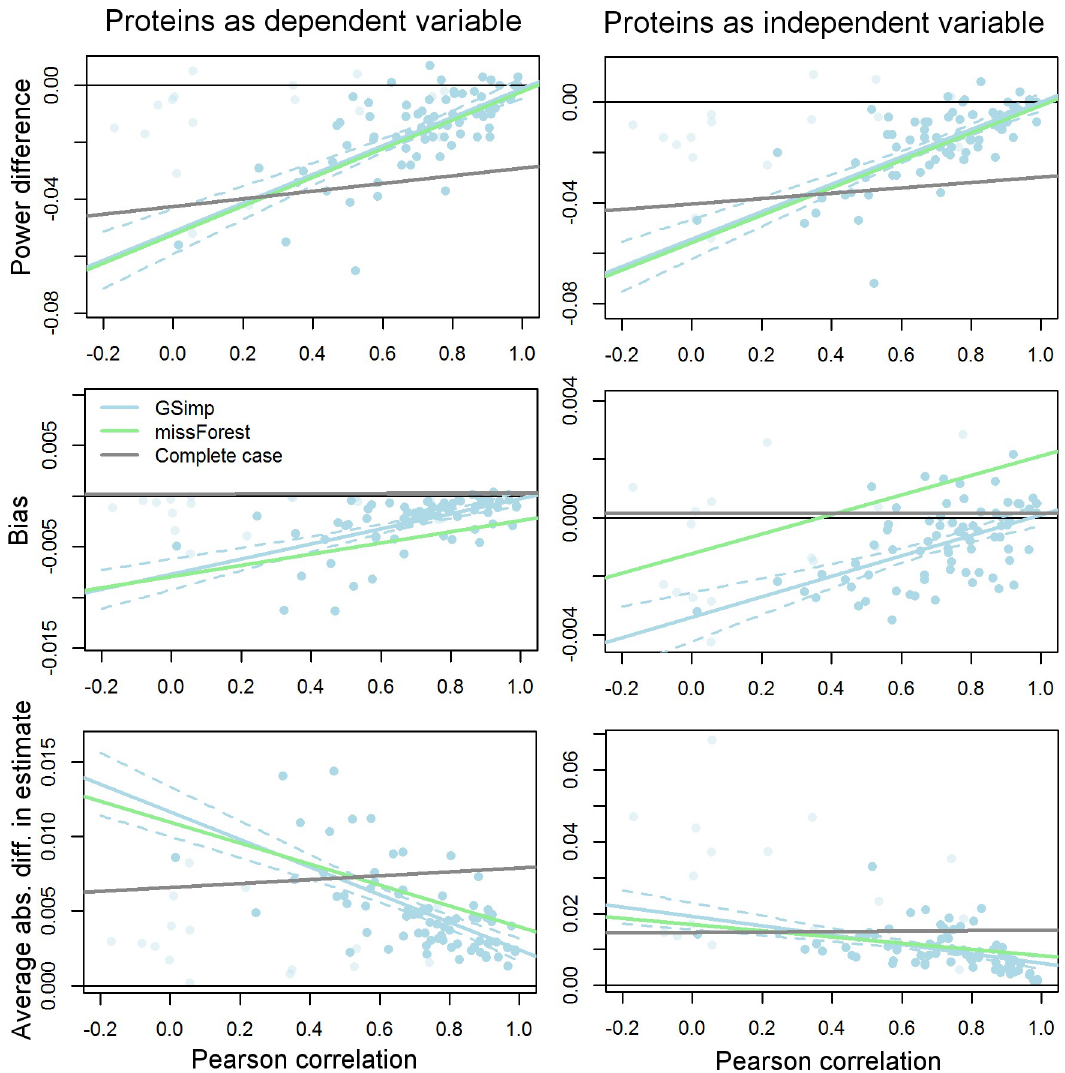
Fig 6. Effect of imputation on downstream analyses. Evaluation of imputation effects on downstream analyses utilizing the proteome data as dependent (left) or independent (right) variable in univariate regression models. The power, bias, and average absolute difference in univariate regression estimates to the complete dataset are shown for GSimp-imputed (light blue dots and lines), missForest imputed (green line), or non-imputed, i.e. complete case, (gray line) data. The simulation utilized all 10 chips, and a beta value of 0.01. For GSimp and missForest, the power increases, and average absolute difference decreases with increasing correlation between imputed and remeasured data. The bias decreases with increasing imputation accuracy when using protein data as dependent variable and crosses zero when using protein data as independent variable. An empirical correlation cutoff of 0.4 (power) or 0.5 (average absolute difference) is observed above which imputation is beneficial compared to no imputation (complete case analysis). Imputation with GSimp results in slightly lower bias and lower absolute average difference compared to missForest for proteins with high imputation accuracy. Proteins with more than 25% of values below LOD are colored transparently and were excluded for calculation of regression